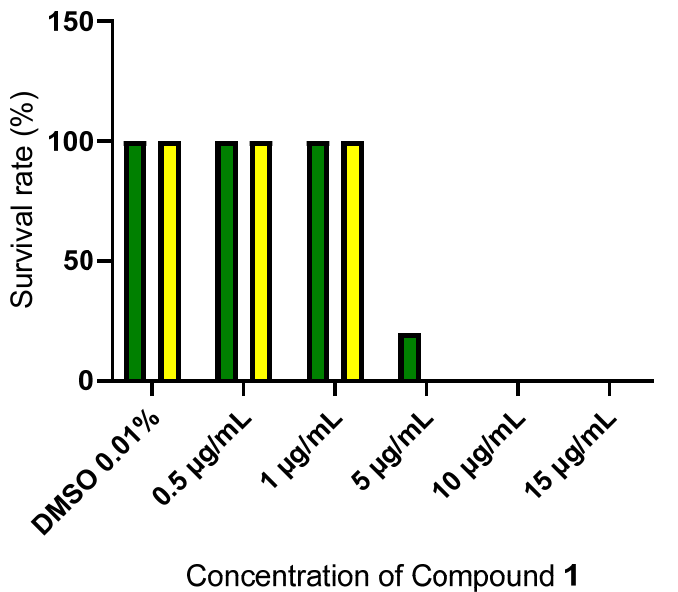
Figure 2. Survival (%) of the zebrafish at 48 (green), and 72 (yellow) hours post fertilization (hpf), exposed to the vehicle (DMSO 0.4%), and Compound 1 (0.5 to 15 µ g/mL). n = 20 embryo/treatment.